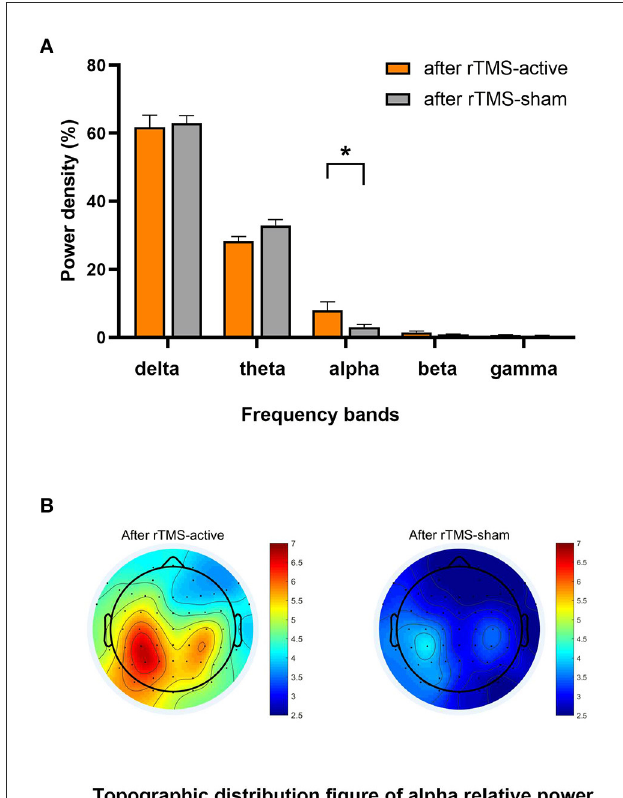
FIGURE3 Result of the general linear model ANOVA showed differences in EEG relative power between-group levels (after rTMS-active and after rTMS-sham). (A) The relative power in five frequency bands. A statistical significance was only found in the relative alpha power (* p < 0.01). The data were expressed as the means ± SEM. (B) There was a difference in whole-brain topographic distribution figure of relative alpha power. Left column: group of after rTMS-active; right column: a group of after rTMS-sham.